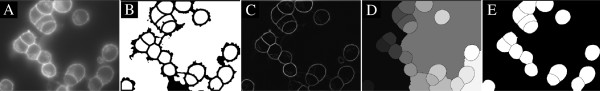
Segmentation of cells in 2D using automatically detected markers in Example 5. A) Raw surface stain, B) automatically detected markers, C) ridge enhanced surface stain, D) watershed image, E) detected cells.